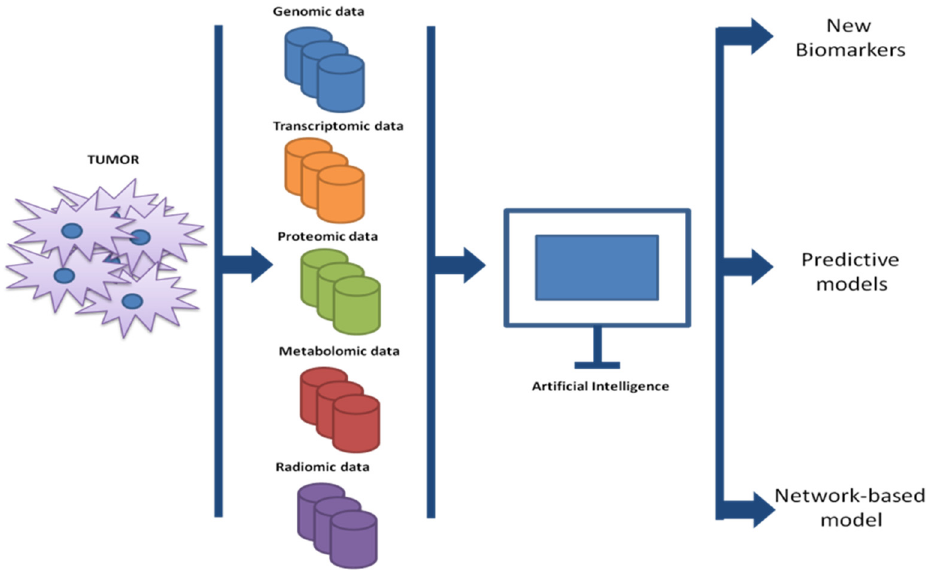
Figure 2. Schematic representation of biobanking and analysis of cancer